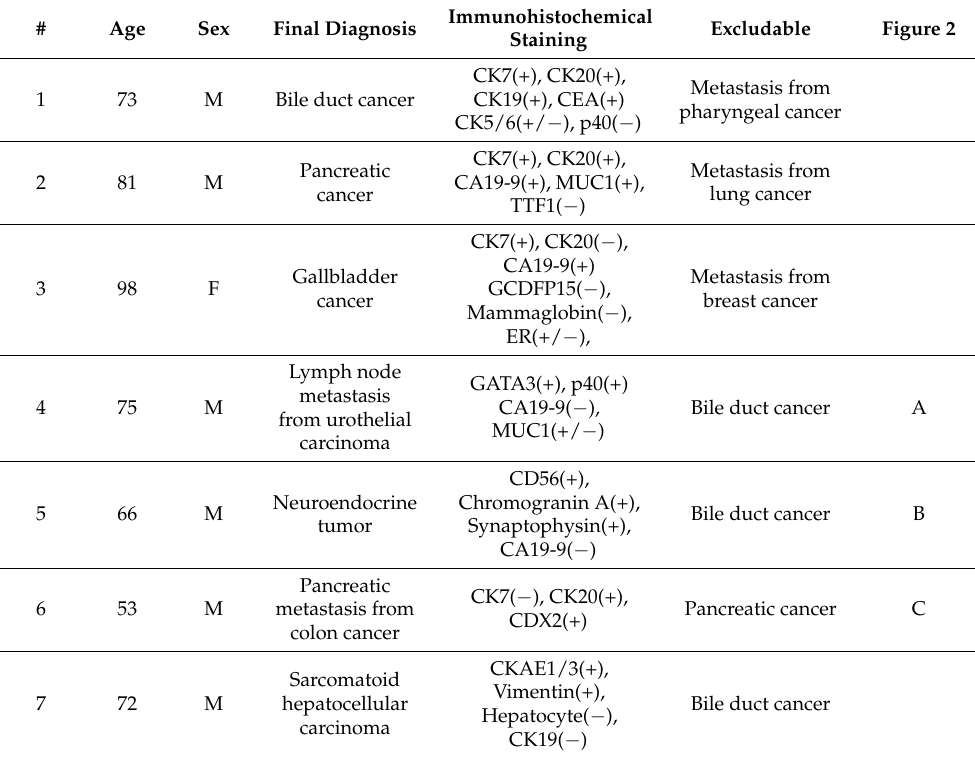
Table 4. Cases in which immunohistochemistry was helpful for differential